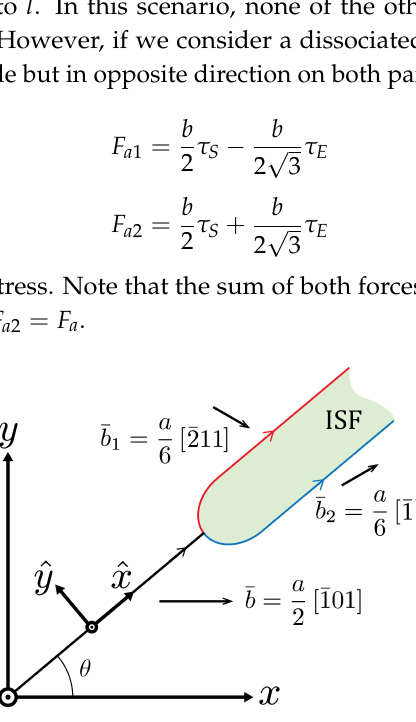
Figure 1. Coordinate systems for a perfect dislocation, its Shockley partials and the intrinsic stacking fault in-between. The arrows along the dislocations represent the line